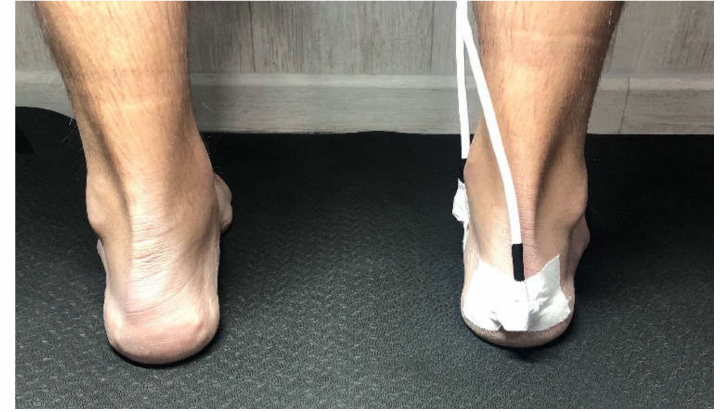
Figure 2. Sensor one. Location placed on the posterior part of the calcaneus.